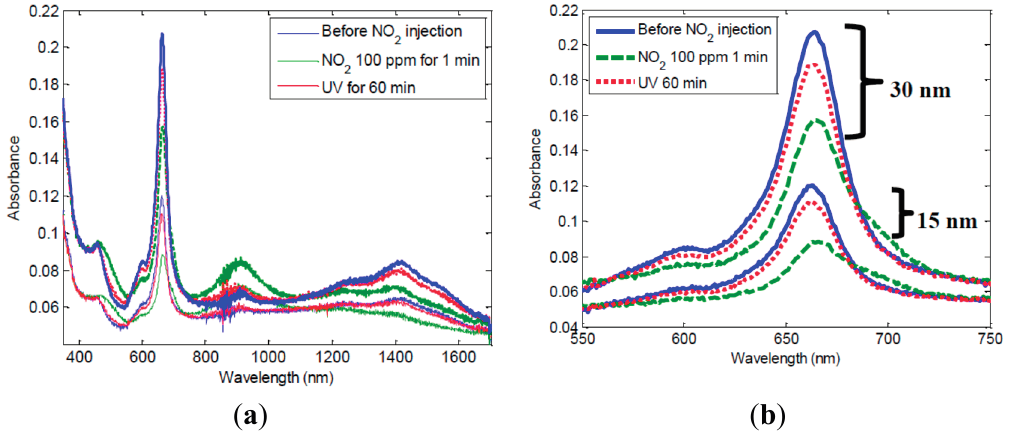
Figure 2. Absorbance spectra of pure LuPc 2 thin films ( a ) whole spectra; ( b ) zoom on 660